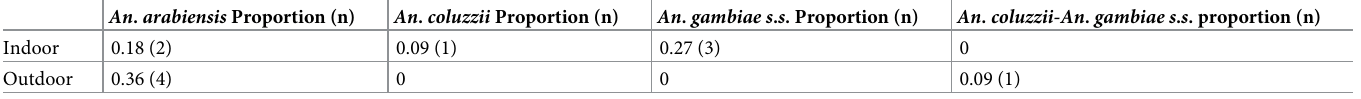
n = number of mosquitoes positive for sporozoite detection. Proportion = the number positive per species divided by overall positive